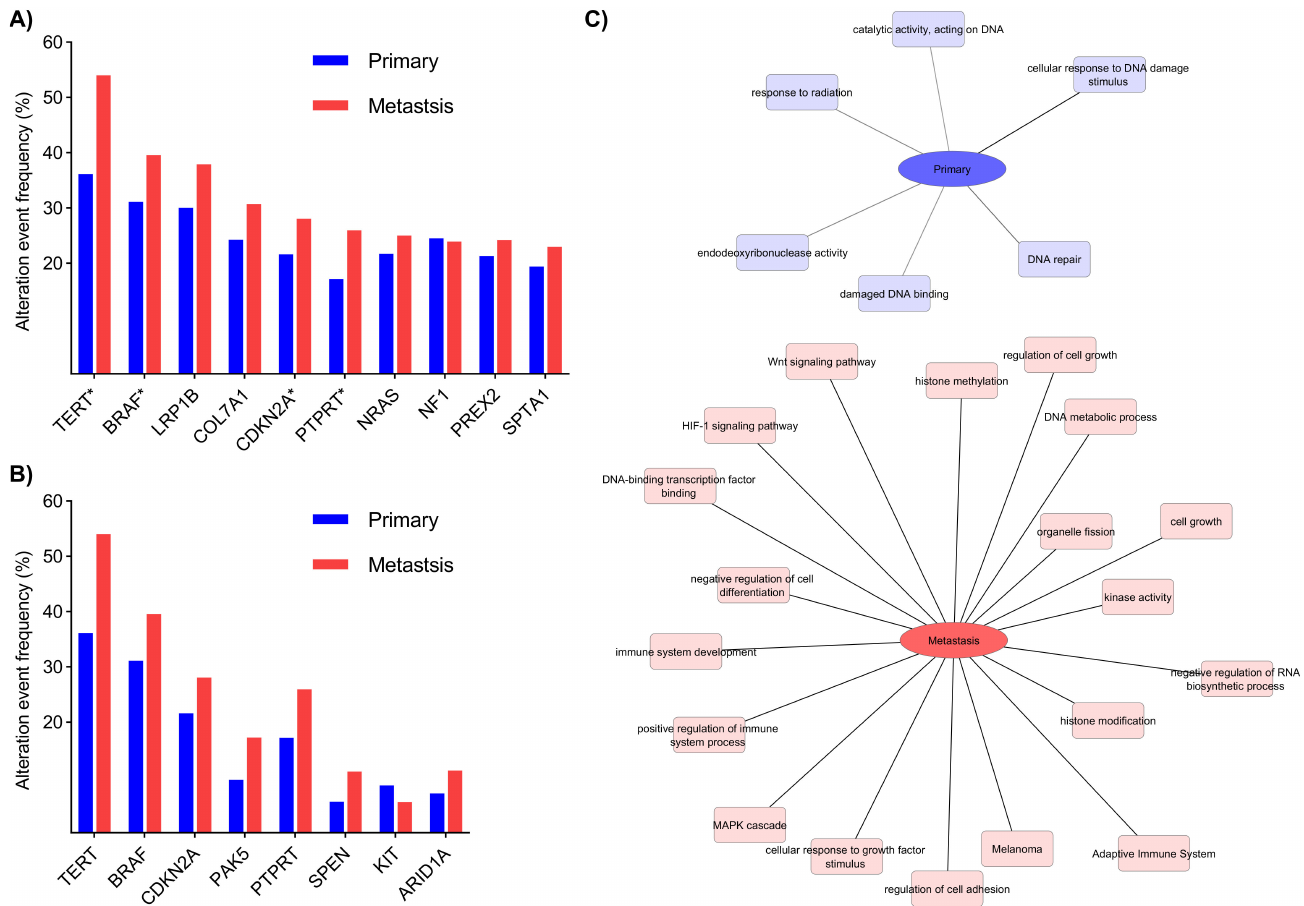
Figure 6. Most frequently mutated genes in primary and metastatic melanoma are involved in key pathways for the development and progression of the disease. ( A ) Genes with the highest frequency alterations among primary and metastatic tumor samples using the project GENIE melanoma dataset. * Denotes significant differences ( p < 0.05) in the frequency of alterations between primary and metastatic tumor samples. ( B ) Genes with significant differences in frequency alterations among primary and metastatic tumor samples ( q -value < 0.05). ( C ) Network representation of the functional clustering analysis of genes with differences in frequency alterations between primary and metastatic melanomas. The genes were filtered based on a p -value 0.05 and the analysis was performed using the ToppCluster function of the ToppGene Suite online version